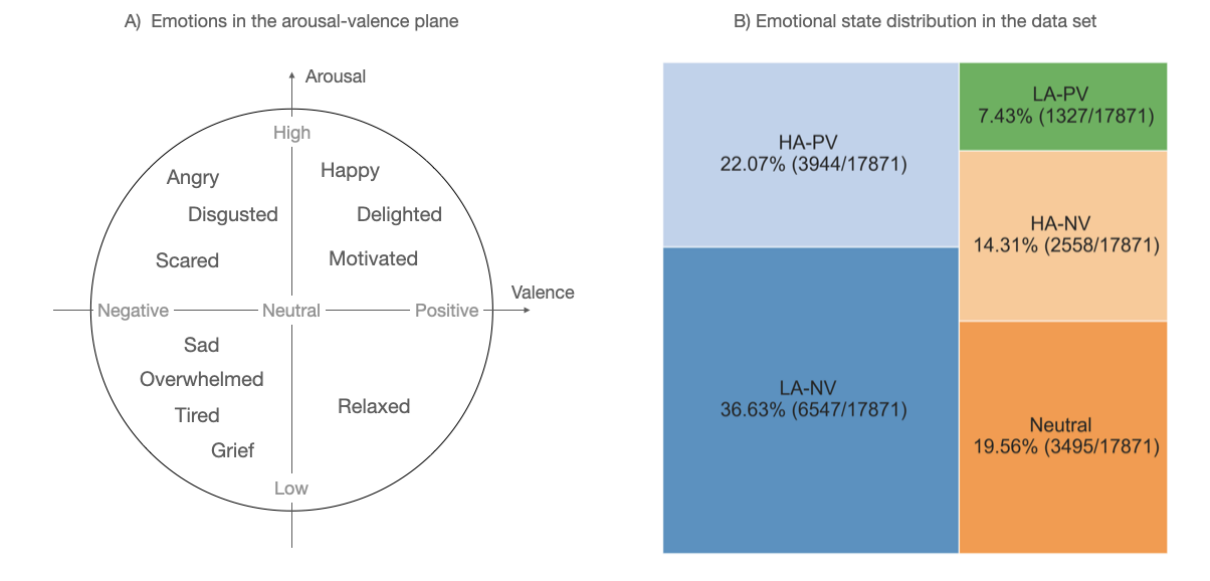
Figure 1. Projection of emotions into the arousal-valence plane and their distribution in the data set. HA-NV: high arousal-negative valence; HA-PV: high arousal-positive valence; LA-NV: low arousal-negative valence; LA-PV: low arousal-positive